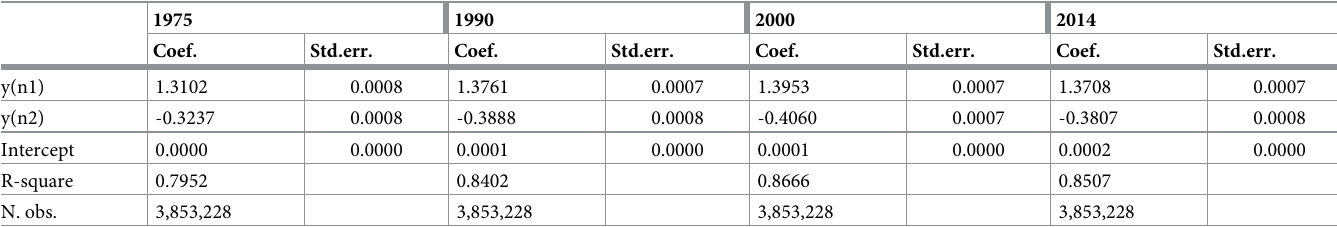
Table 7. Correlation in buildup between neighboring cells.